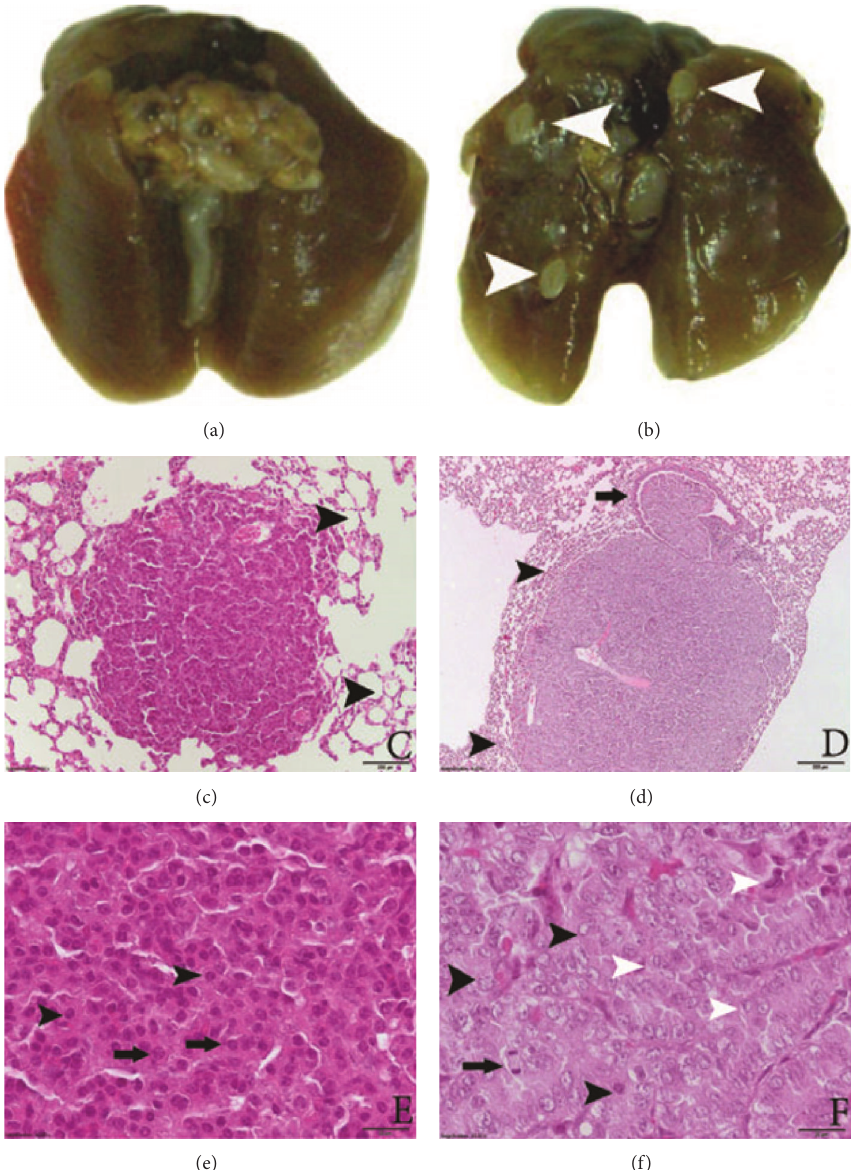
Figure 1: Lung specimens. (a) Control. (b) Urethane-induced lung tumors (white arrowheads). (c) Adenoma, magnification × 4, H & E staining. There are no signs of pressure to surrounding tissues; alveoli are well preserved (black arrowheads). (d) Adenocarcinoma, magnification × 4,H&Estaining.Compressionofsurroundingalveoli(blackarrowheads).Invasiontothelumenofbronchiole(blackarrows). (e) adenoma, magnification × 40, H & E staining. All nuclei are of similar size and shape; no nucleoli are present (black arrowheads). Cells are of similar size and shape (black arrows). (f) Adenocarcinoma, magnification × 40, H & E staining. Pleomorphic nuclei (black arrowheads), mitotic figures (black arrow), and different cell shapes and sizes (white arrowheads). Scale bar: (c and d) 200 𝜇 m; (e and f) 20 𝜇